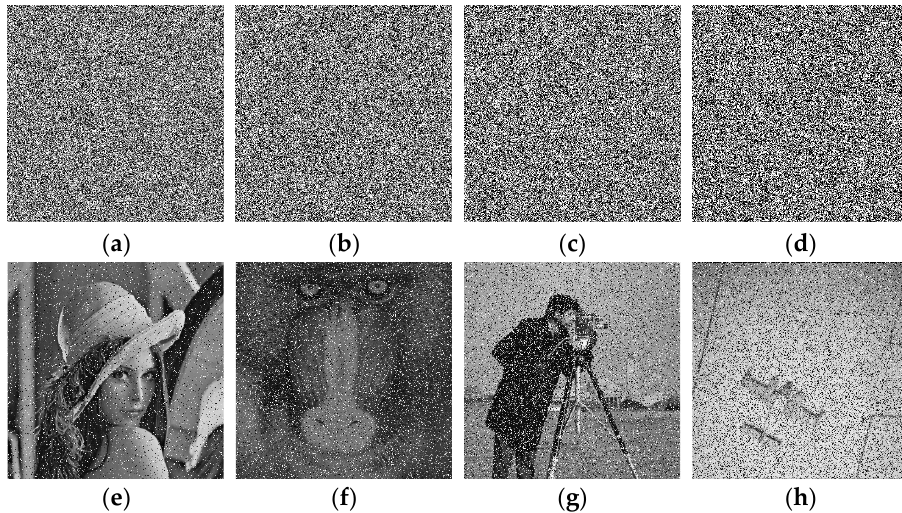
Figure 10. Pepper and salt noise attacks with different densities: ( a ) Lena cipher image by accumulating pepper and salt noise with noise density 0.1; ( b ) baboon cipher image by accumulating pepper and salt noise with noise density 0.2; ( c ) cameraman cipher image by accumulating pepper and salt noise with noise density 0.3; ( d ) airplane cipher image by accumulating pepper and salt noise with noise density 0.4; ( e ) the decrypted image obtained from ( a ); ( f ) the decrypted image obtained from ( b ); ( g ) the decrypted image obtained from ( c ); and ( h ) the decrypted image obtained from ( d ).